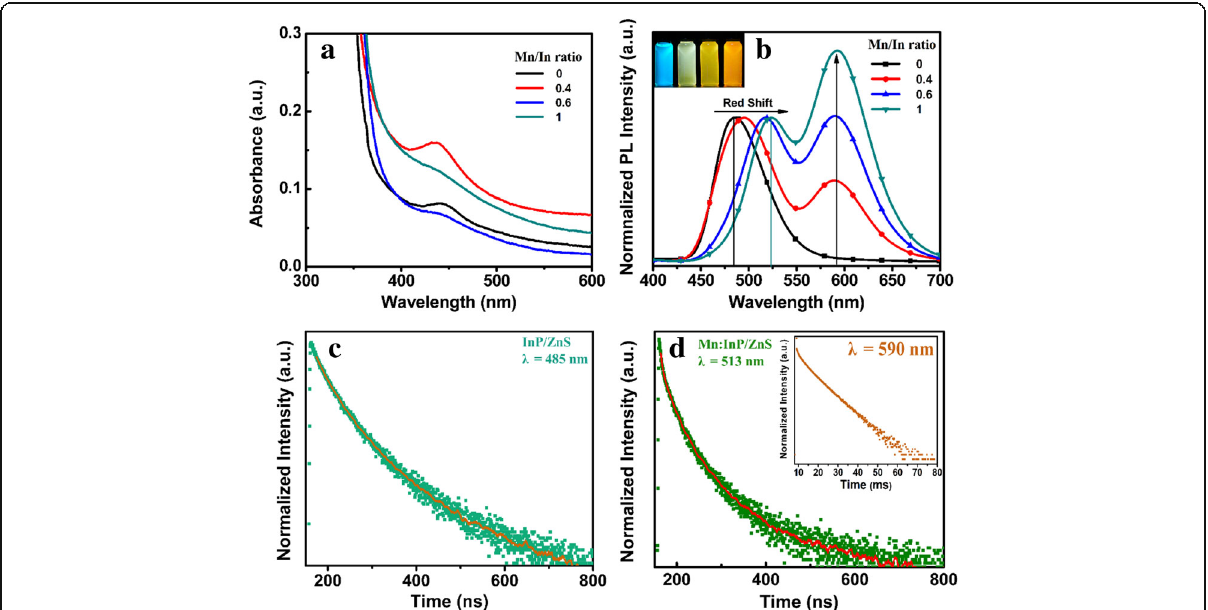
Fig. 4 a The UV-vis absorption and b PL spectra of Mn:InP/ZnS QDs ( λ ex =360 nm) with different Mn/In ratios. Time-resolved PL decay curves of c InP/ ZnS QDs with emission wavelength of 485 nm, λ ex = 360 nm and d Mn:InP/ZnS with emission wavelength of 513 and 590 nm, λ ex = 360 nm (Mn/In = 0.6). The solid lines represent fitting curves